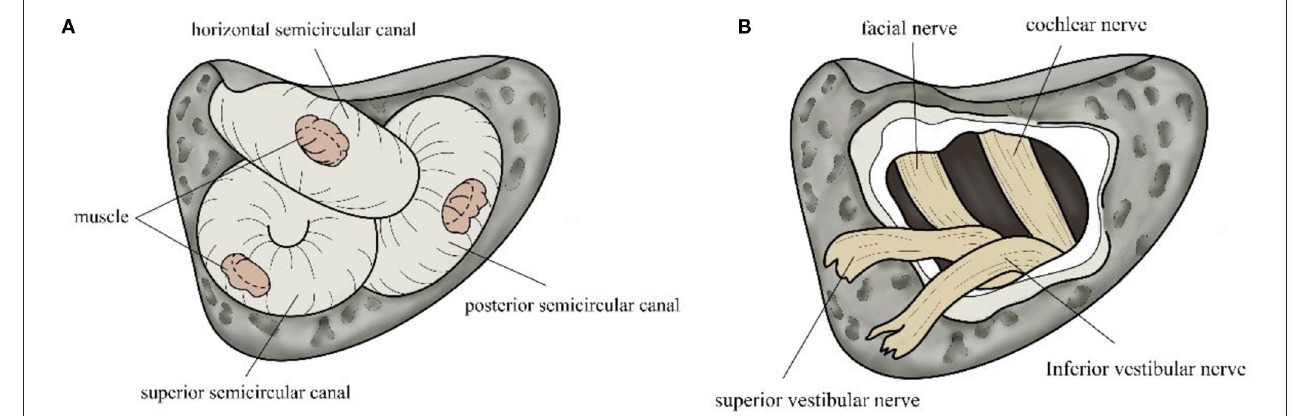
FIGURE 1 | Diagram of triple semicircular canal occlusion and vestibular nerve resection. (A) Muscle tissue blocks the three semicircular canals, which are clearly contoured. (B) The vestibular is cut off after being separated from the cochlear nerve.